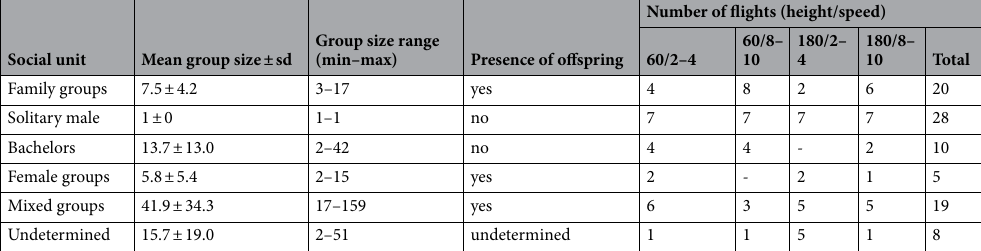
Table 1. Summary of the social units in which we conducted the flights, indicating mean group size (± standard deviation), group size range, presence of offspring and number of flights conducted (n = 90). In 8 flights, we could not determine the social unit (undetermined). Height is expressed in metres AGL and speed in m s -1